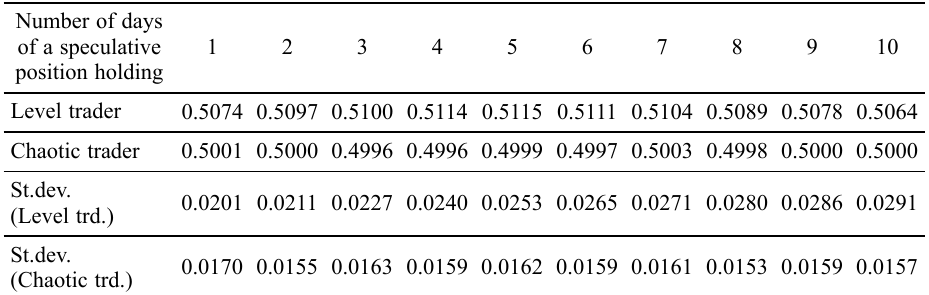
Table 8. Results of level trading